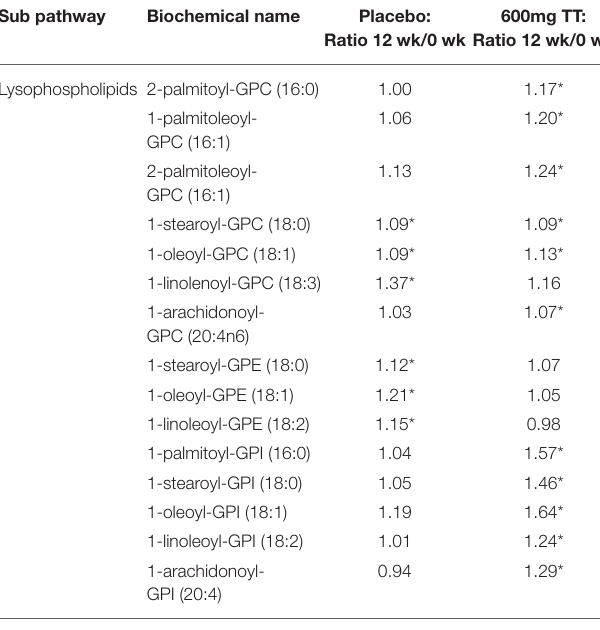
TABLE 5 | Changes in metabolites associated lysophospholipids in serum of the Placebo and the 600mg TT groups at 0 and 12 wk. Sub pathway Biochemical name